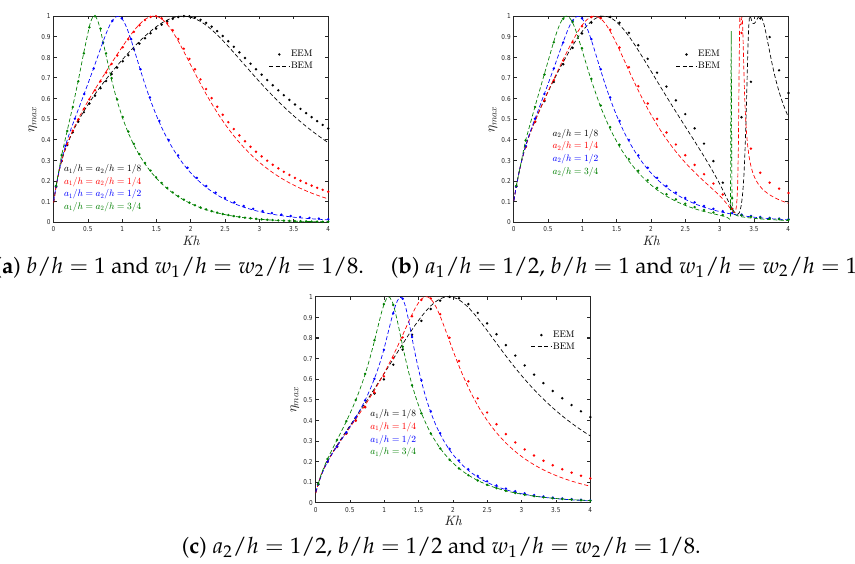
Figure 6. Maximum hydrodynamic efficiency η max versus the non-dimensional frequency Kh for different ( a ) submergence depths of the rear and front walls, a 1 / h and a 2 / h , respectively; ( b ) submer- gence depths of the front wall a 2 / h ; ( c ) submergence depths of the rear wall a 1 / h .